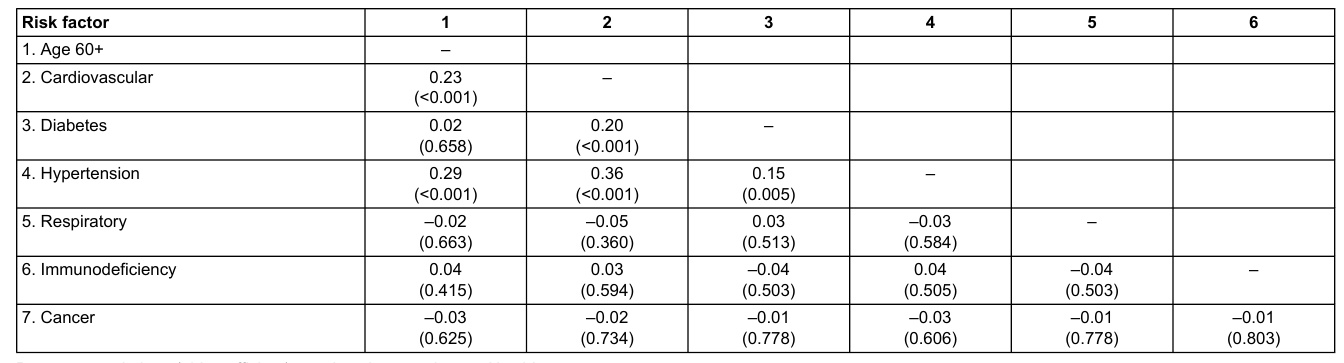
Table 1: Correlation between risk